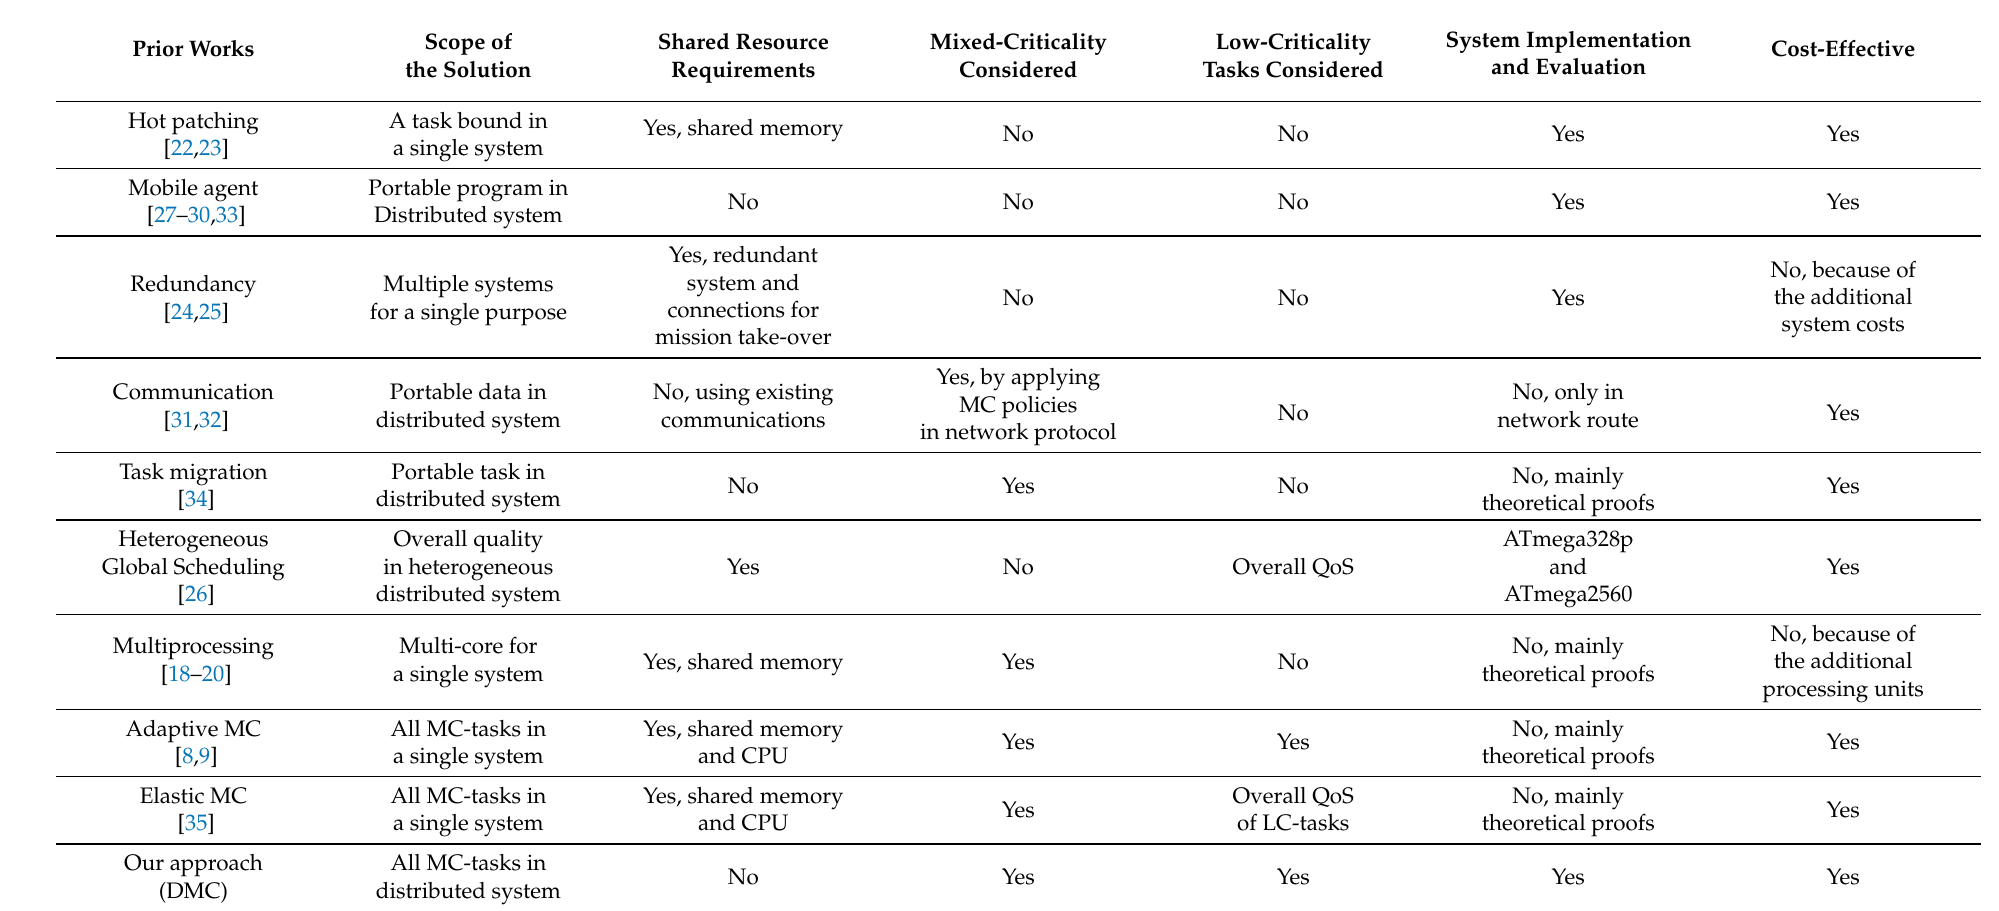
Table 6. Comparison of a selection of previous